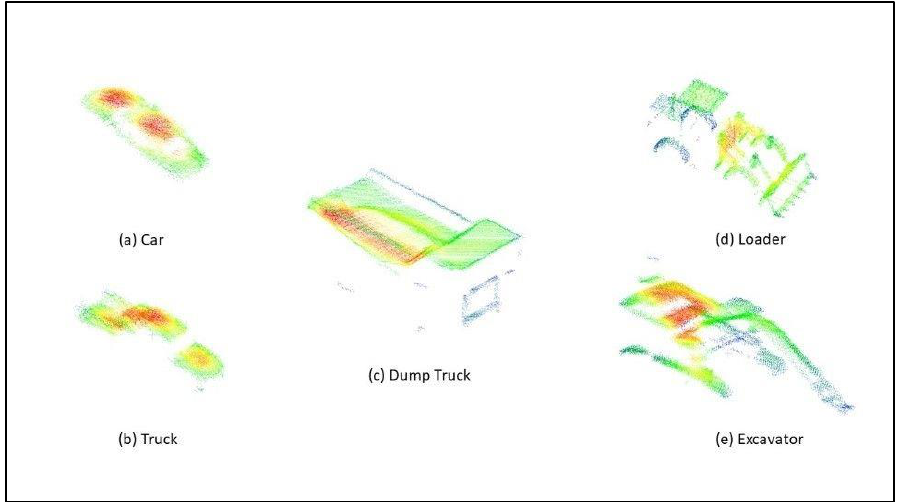
Figure 4. The images show an example of the point clouds for the five objects: ( a ) car, ( b ) truck, ( c ) dump truck, ( d ) loader, and ( e ) excavator. Coloring of the point clouds is by surface density.